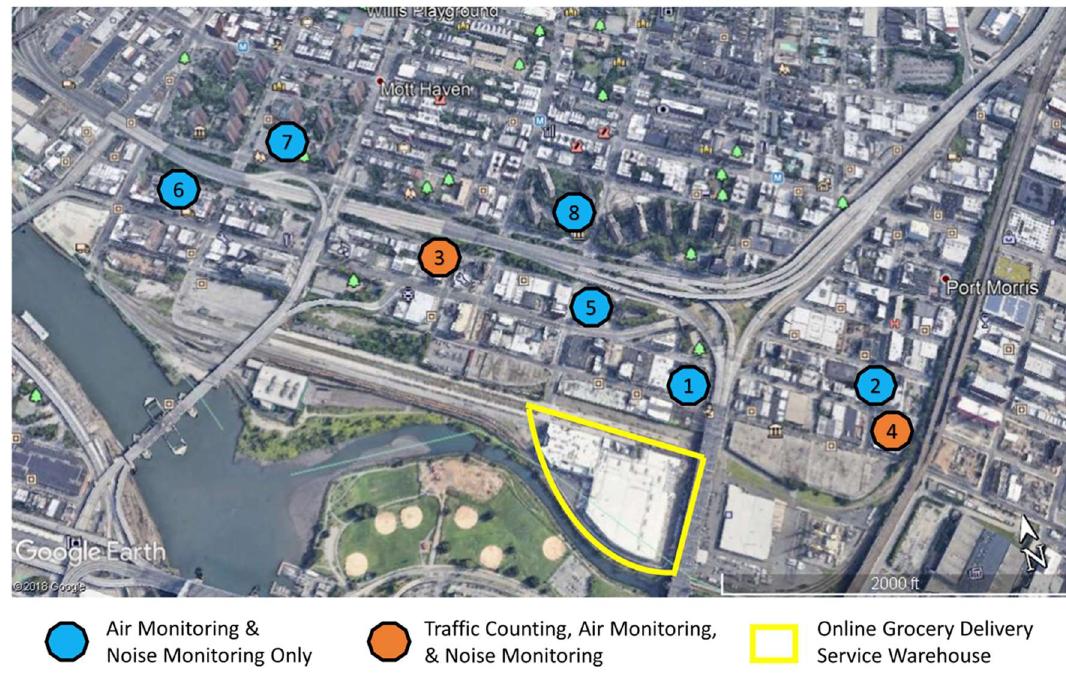
Figure 1. Study site, including locations used for traffic counting, air quality measures, and noise measures.